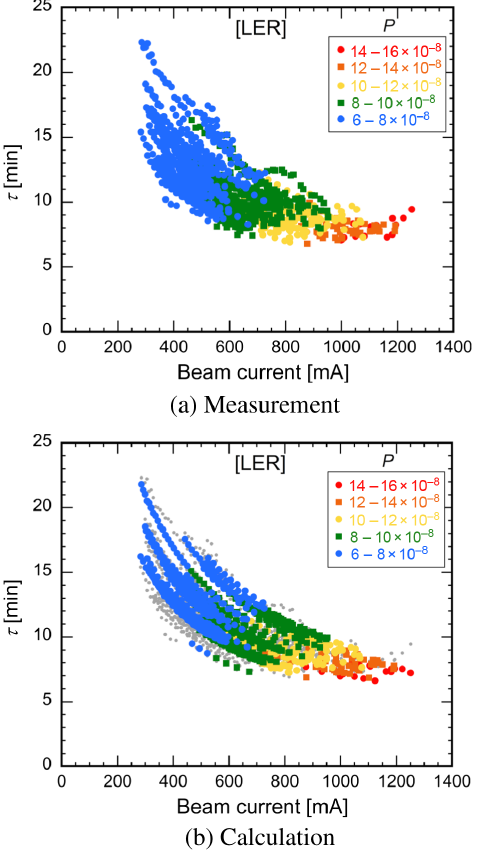
FIG. 14. Dependence of τ on I (a) measured and (b) calculated using the regression curve for several pressure ranges of 6 × 10 − 8 – 1 . 6 × 10 − 7 Pa for the LER, where the data from the 15th of May to the 21st of June 2022, were used for the MRA. Gray points represent all measured